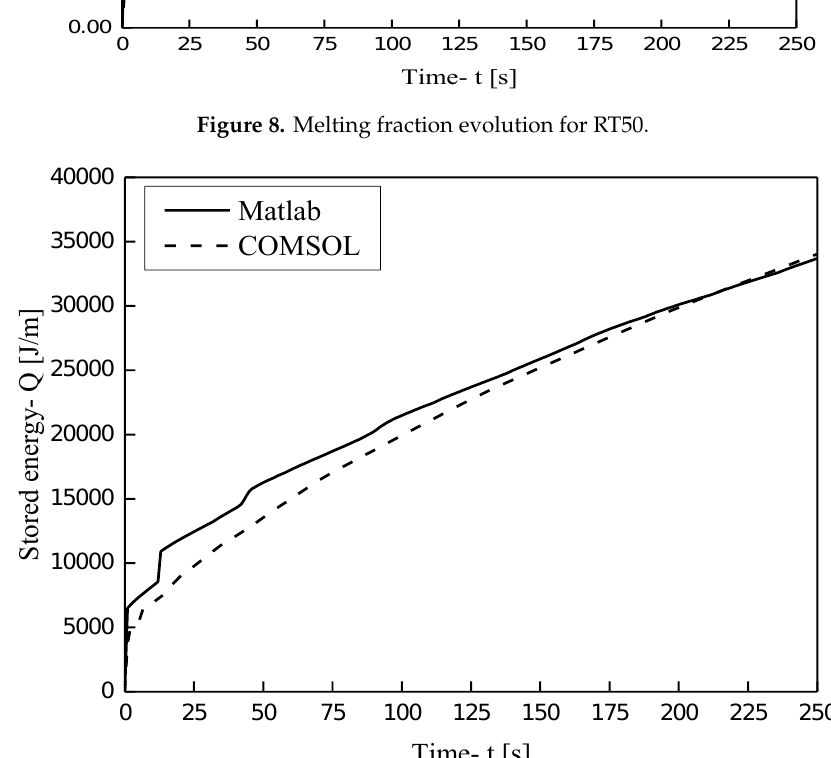
Figure 9. Stored energy during the interval 0–250 s.